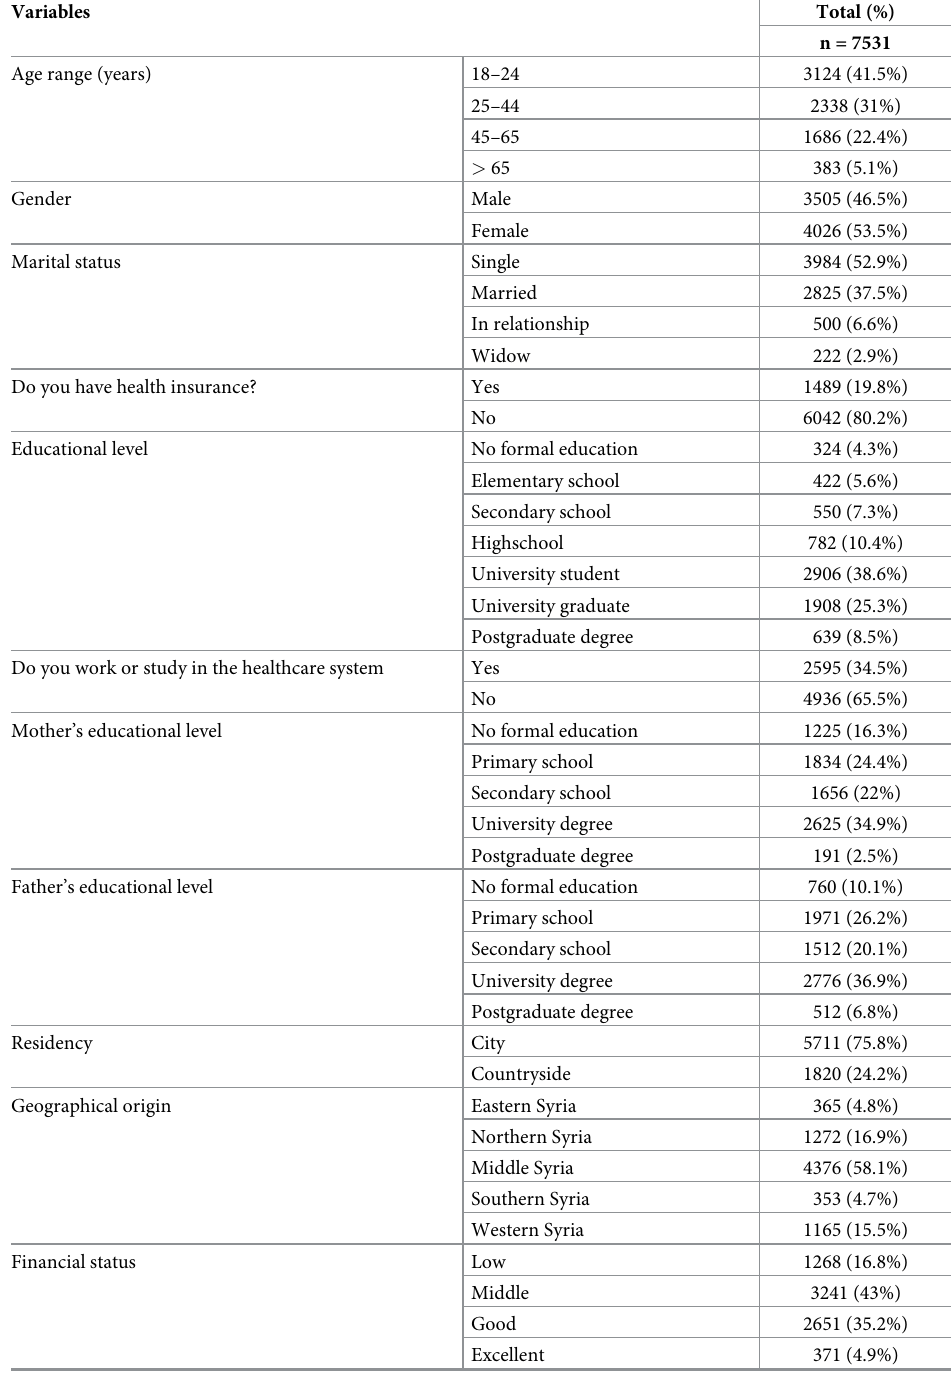
Table 1. Participant’s